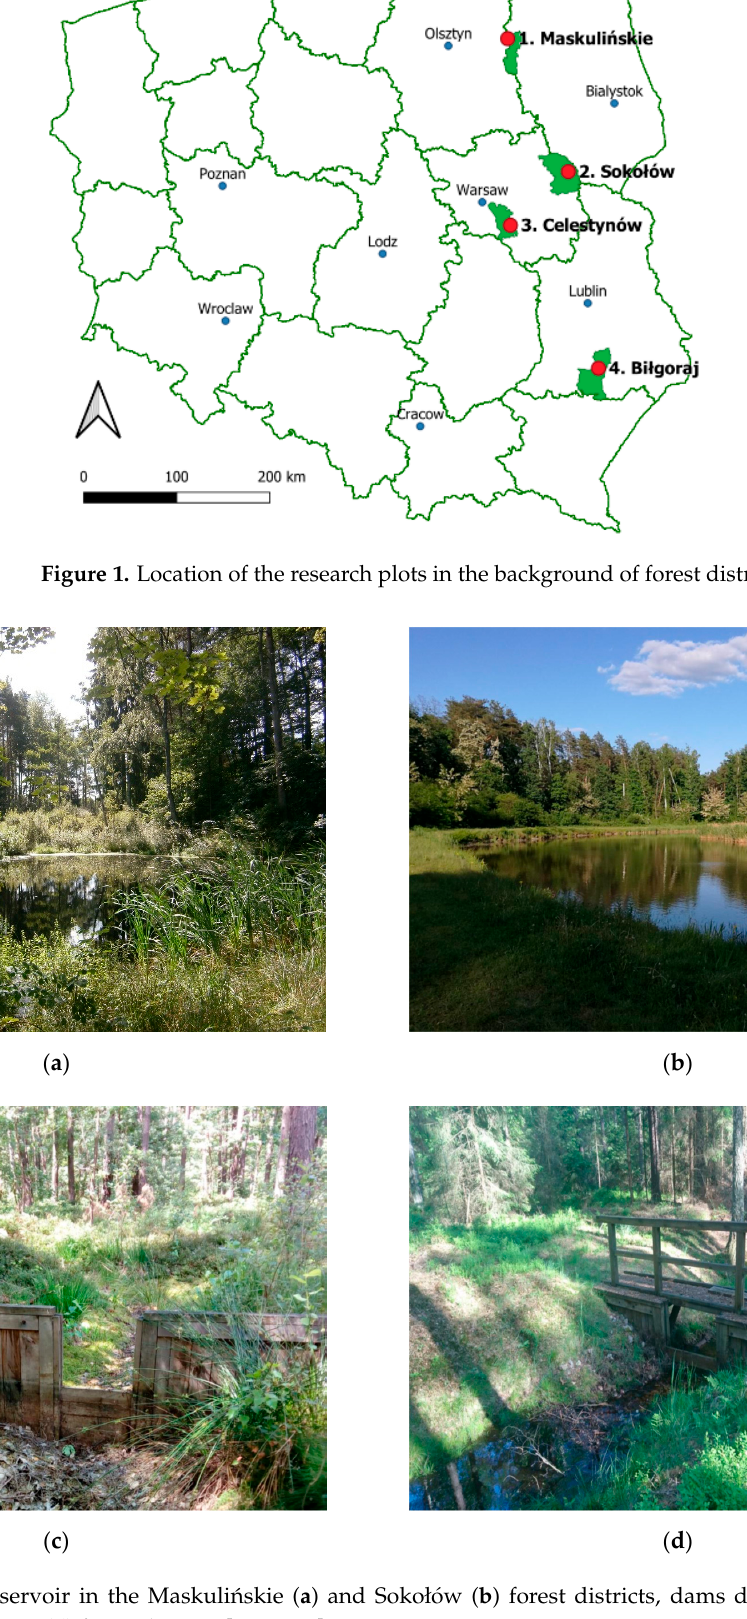
( d ) Figure 2 . Retention reservoir in the Maskuli ń skie ( a ) and Soko ł ów ( b ) forest districts, dams damming water in the Celestynów ( c ) and Bi ł goraj ( d ) forest districts [19,47–49].